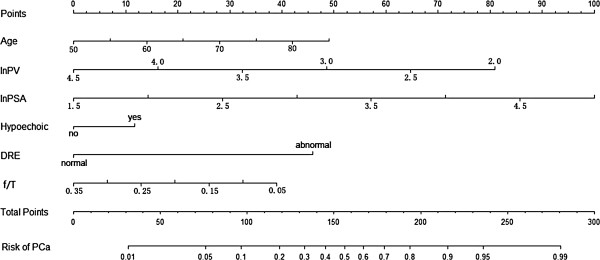
Nomogram for predicting a positive rate. Locate patient values on each axis, and compare to the ‘Point’ axis to determine how many points are attributed to each variable. Then locate the sum of the points for all variables on the ‘Total Points’ line to determine the individual probability of prostate cancer on the ‘risk of PCa’ line.